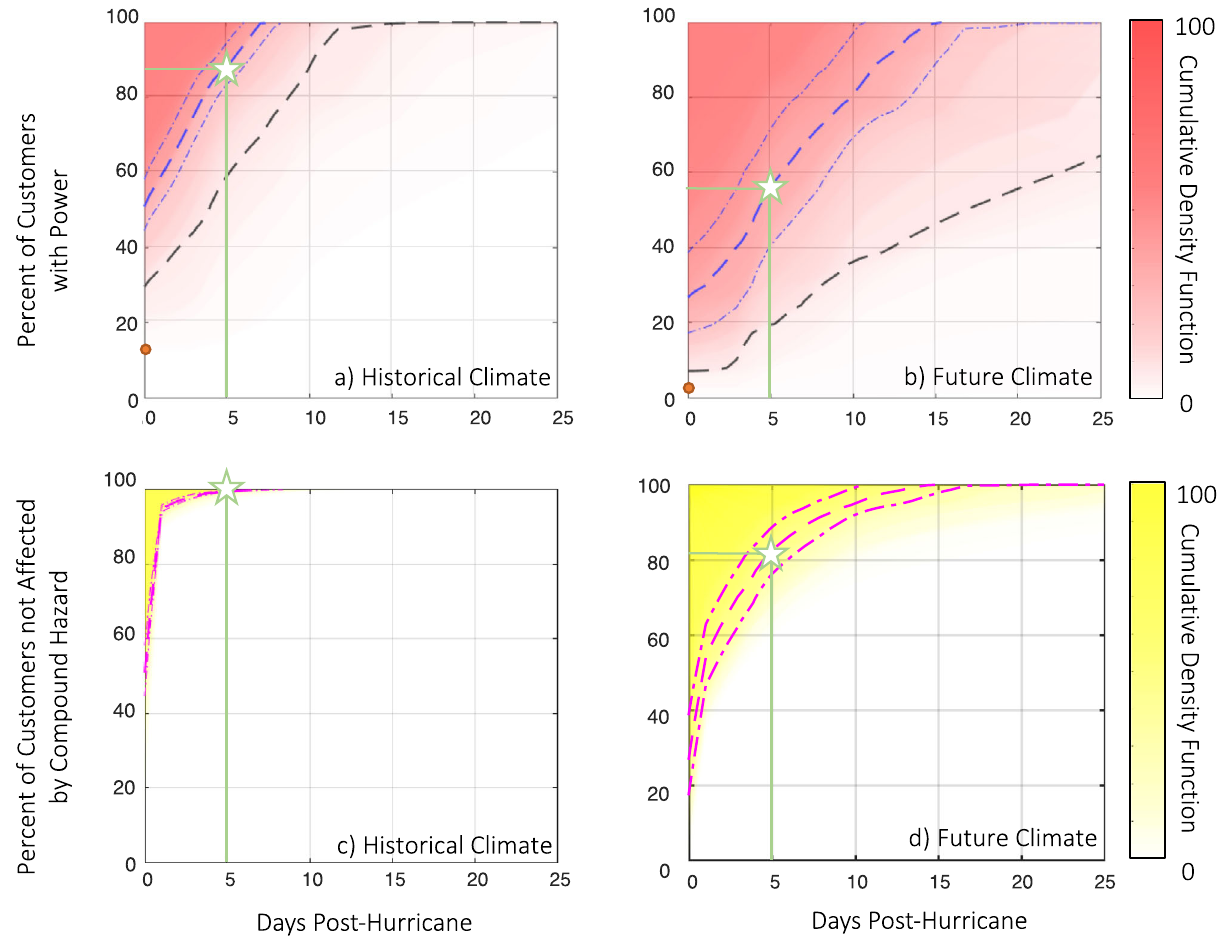
c the historical climate and d the future climate. In all panels, the dashed and dashed-dotted curves show expectation and ±1 σ range based on all simulations. The shade shows CDF, indicating the probability of less than a certain (y) percen- tage of residents not affected, with a darker color corresponding to higher prob- ability and thus higher risk. Green stars highlight the expected percentage of residents not affected 5 days post-TC